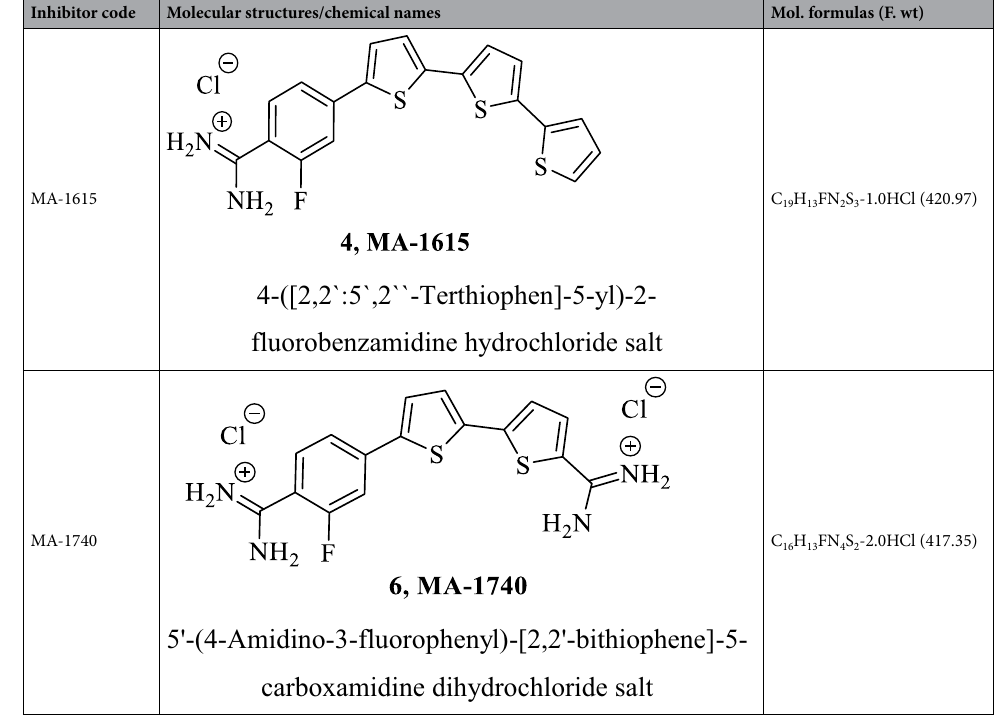
Table 2. Molecular structures, formulas, weights of bithiophene